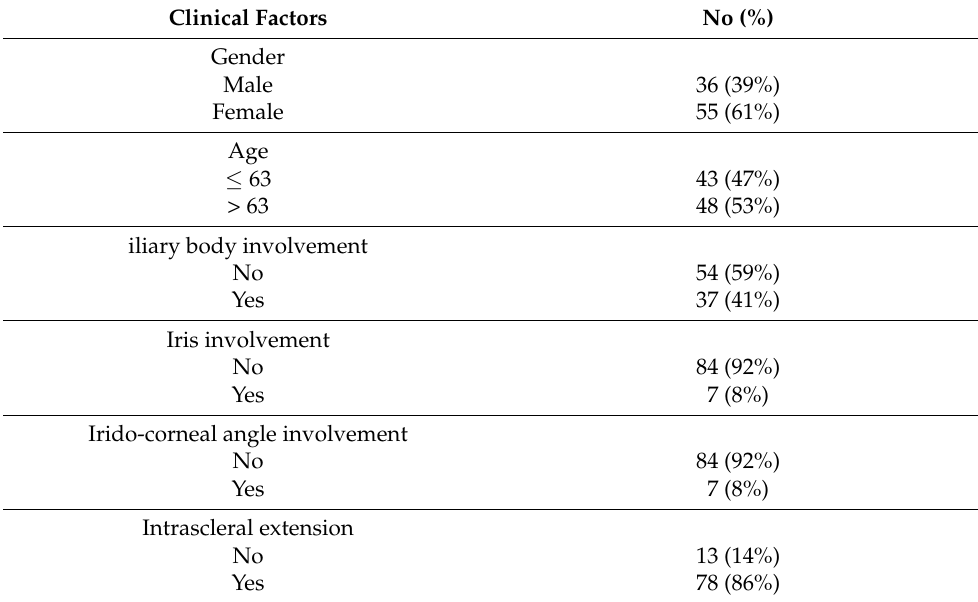
Table 1. Clinicopathological characteristics of the study